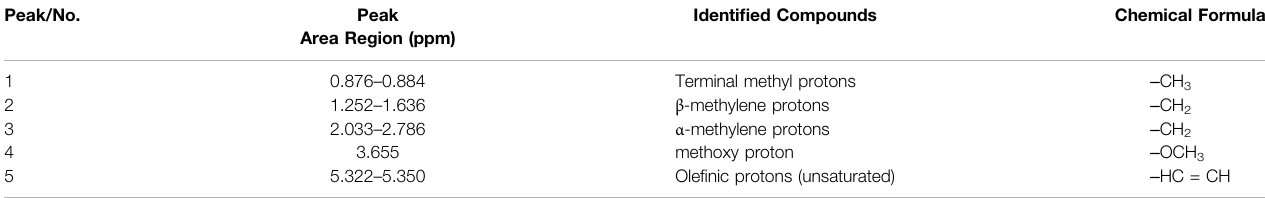
TABLE 5 | H 1 NMR spectrum of Cucumis melo var. agrestis biodiesel. Peak/No.